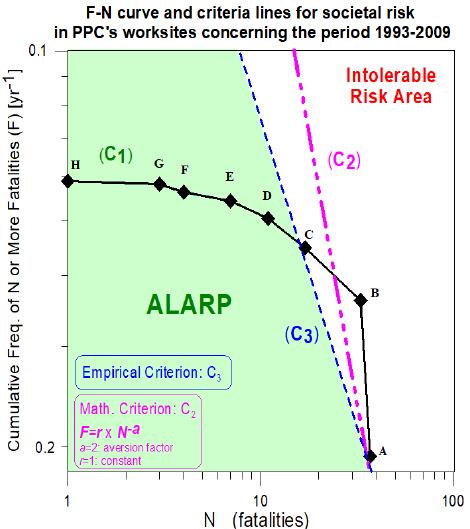
Figure 5. Example of the combination of two absolute RACs (the “mathematical” and the “empir- ical”) with an F-N curve in order to define the intolerable and the ALARP risk region in the OHSRA system of an energy-production industry (adapted from the work of Marhavilas and Koulouriotis, 2012) [29].